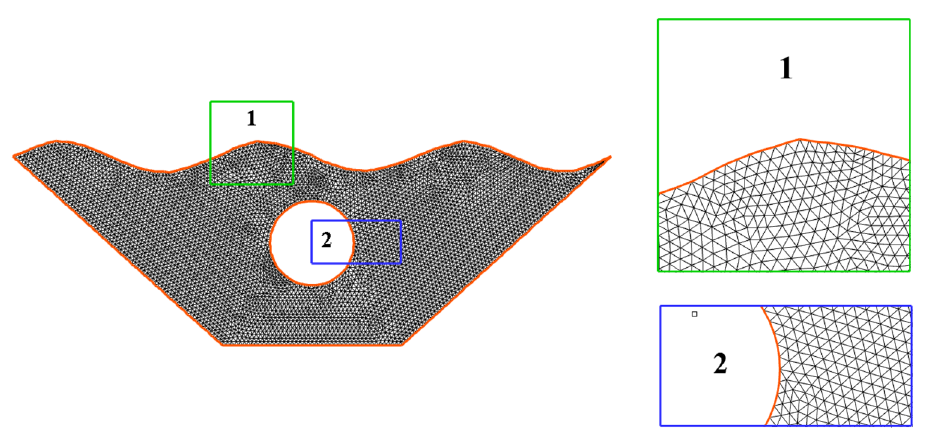
Figure 3. Adaptive mesh